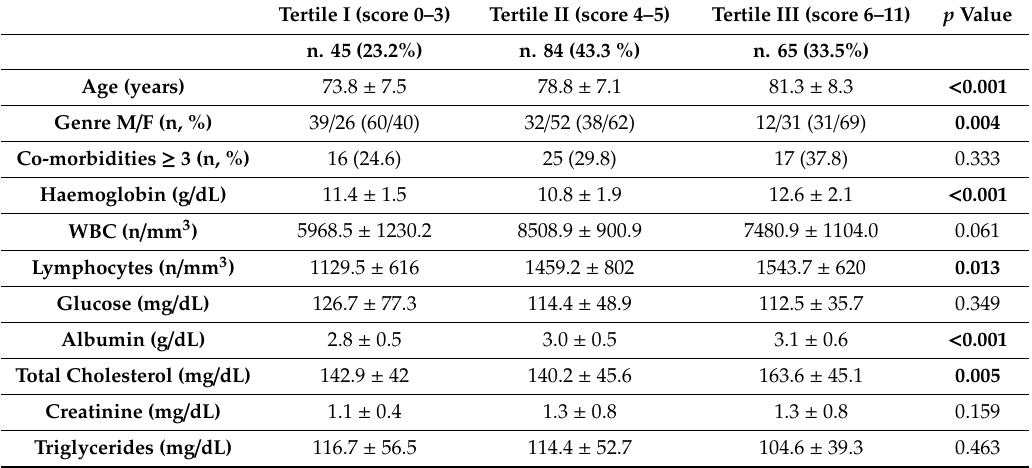
Table 1. Clinical and biochemical characteristics of patients at baseline, according to study